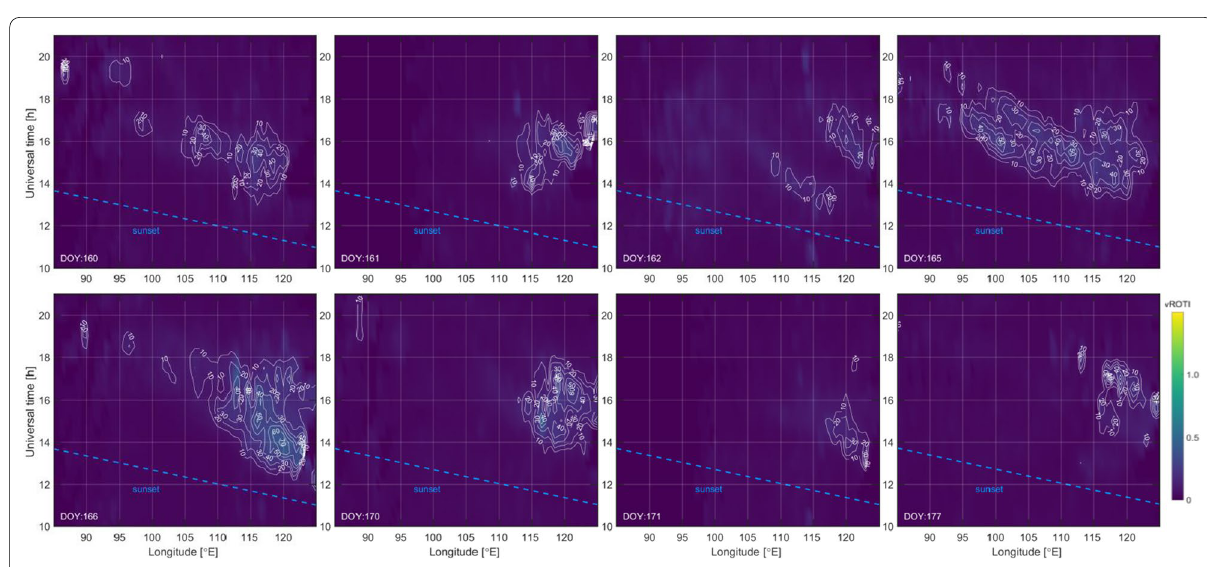
Fig. 6 Keograms based on CMONOC in June